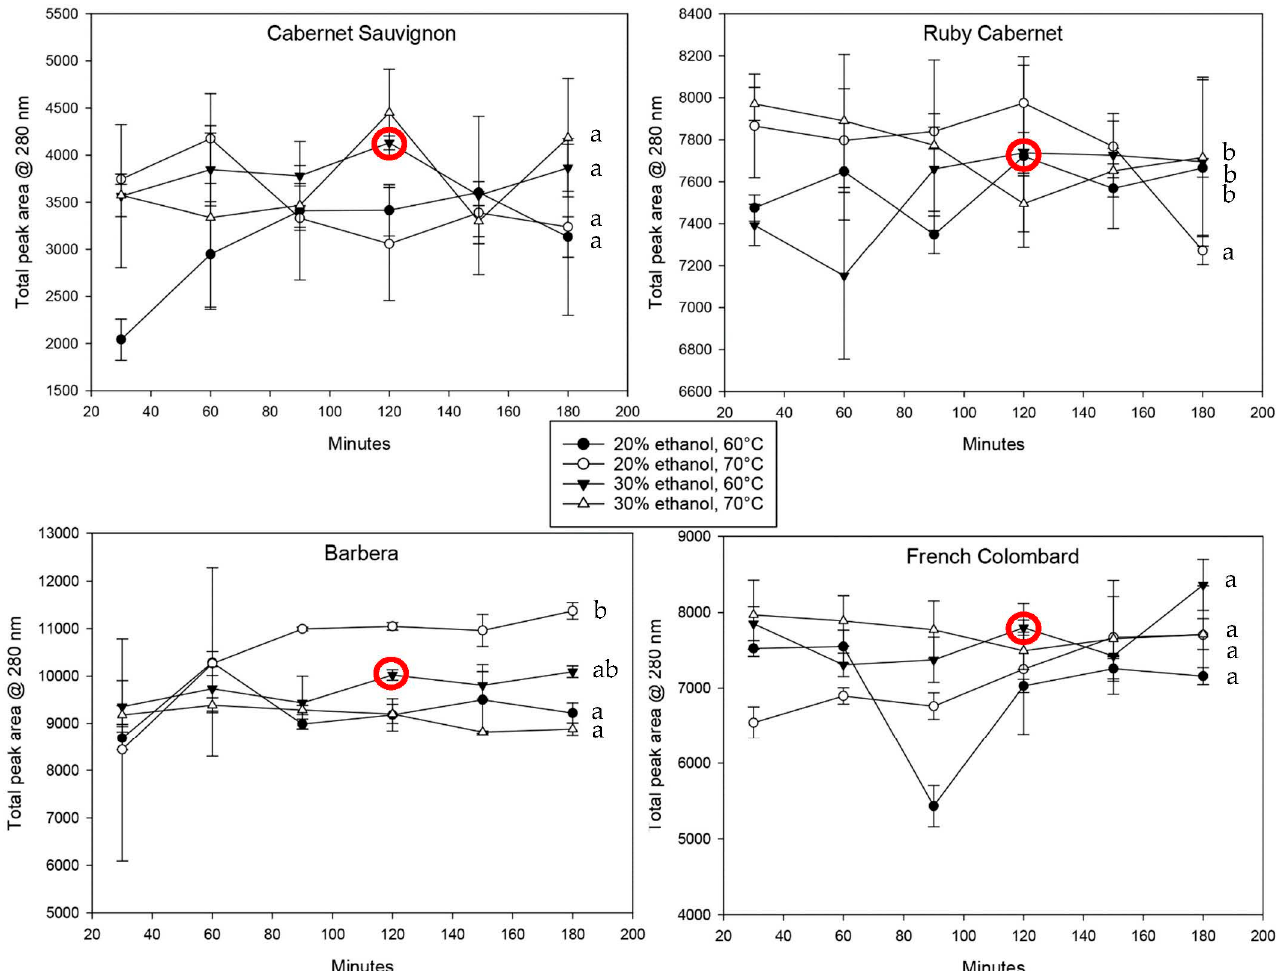
Figure 3. Liquid chromatography analysis of the monomeric phenolic material in leaf tissue extracts over time at 280 nm. Extracts are shown for four cultivars using different temperature-solvent strength combinations. The red circle indicates the extraction conditions that were chosen for the proposed method. Statistically significant differences ( p < 0.05) within each dataset are indicated using le tt ers a, b.